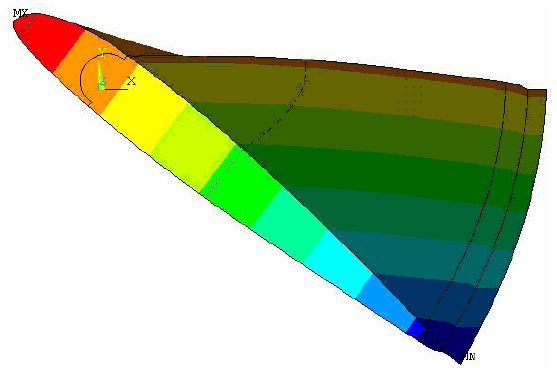
Fig 4. Torsion angle of the helicopter rotor